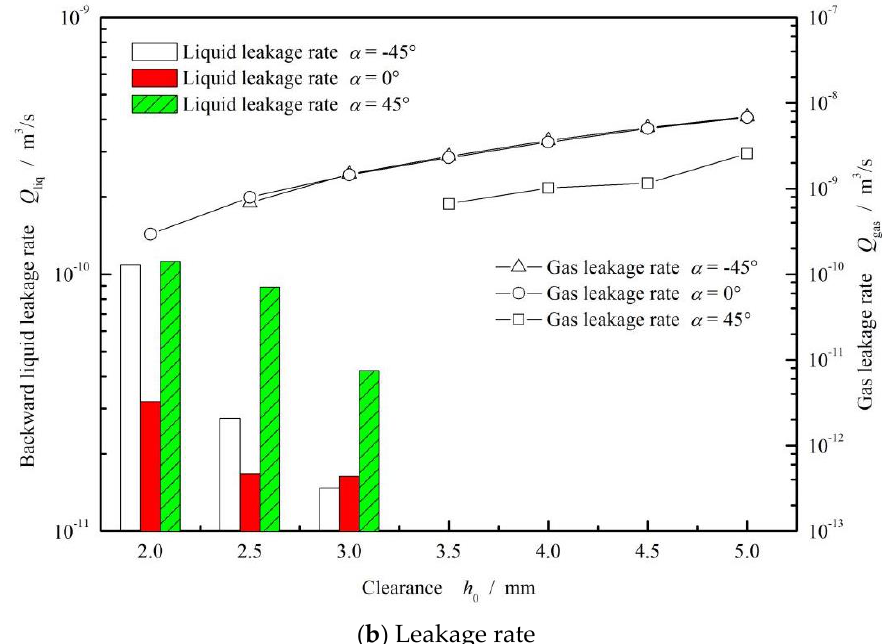
Figure 5. Effect of seal clearance on the opening force ( a ) and leakage rate ( b ) ( ω = 10,000 rpm, p o = 0.3 MPa, h 0 = 2 μm, γ = 3.5 and N = 36).